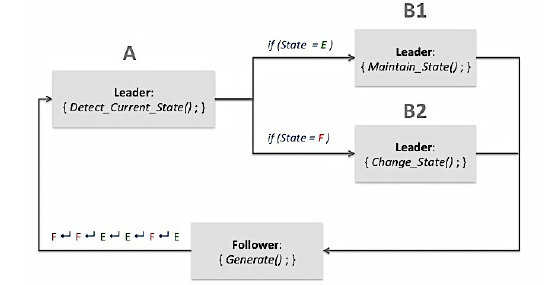
Fig. 3. Cognitive rules of leadership for